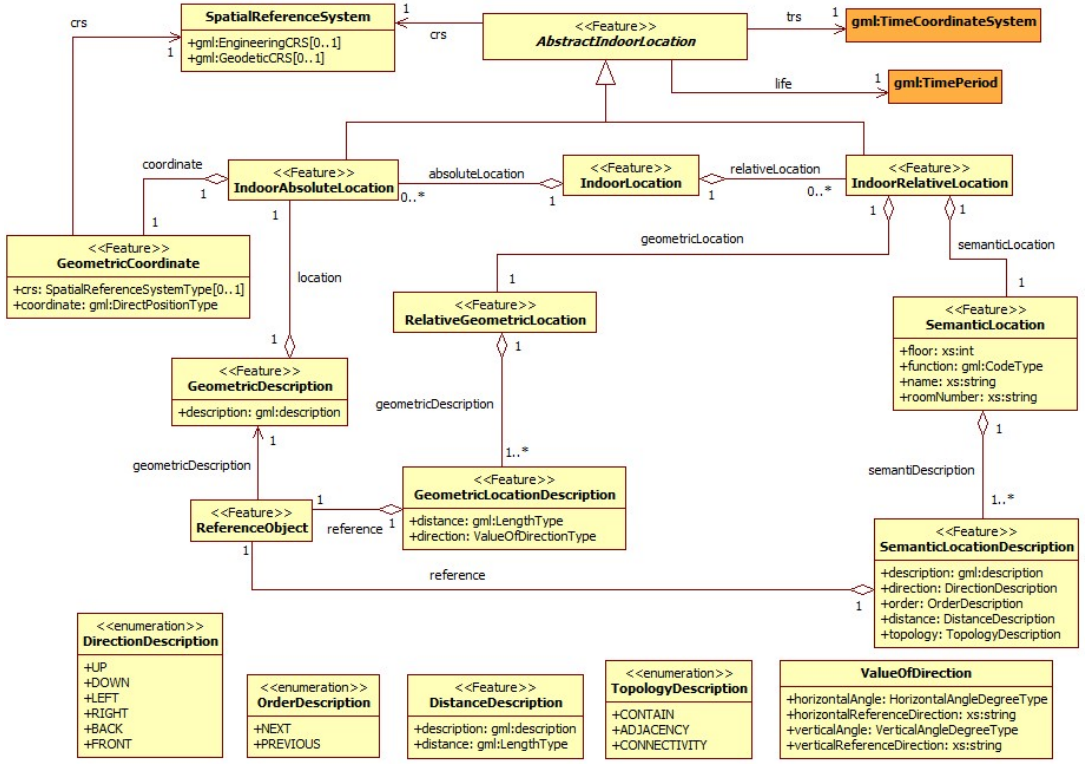
Figure 1. UML diagram of indoor multi-dimensional location information.